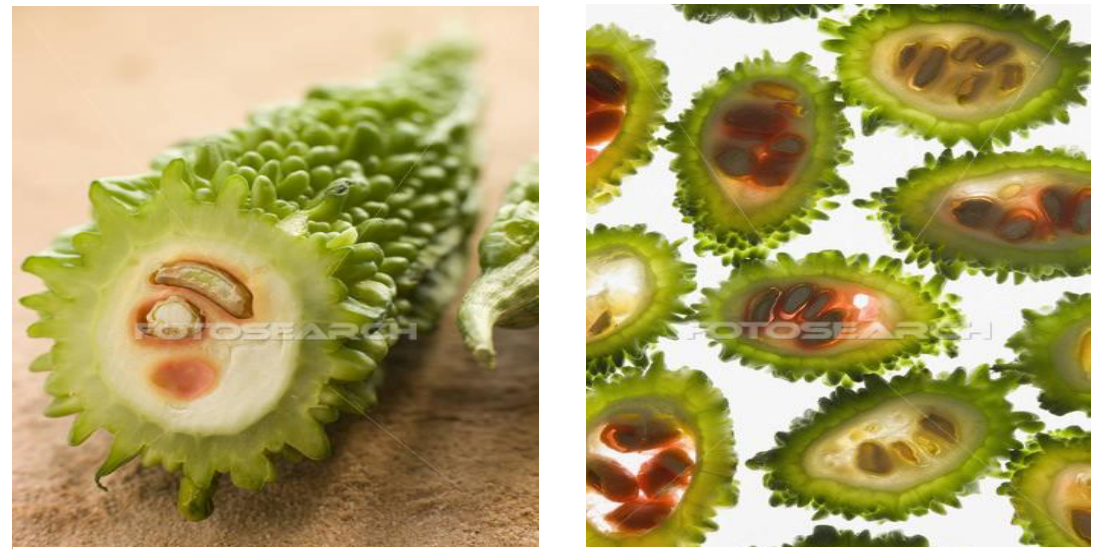
Figure 1 : Plant of Momordica